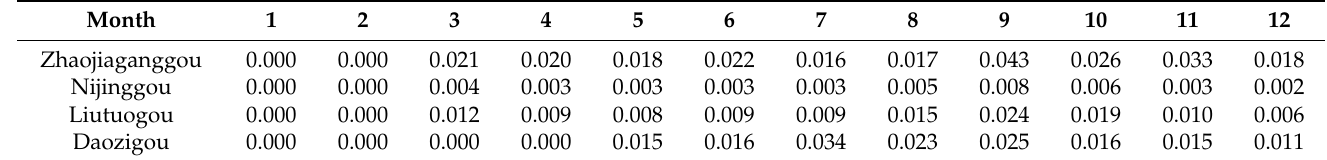
Table 1. Ratio between the runoff discharge in upstream rivers and that in the Luanhe